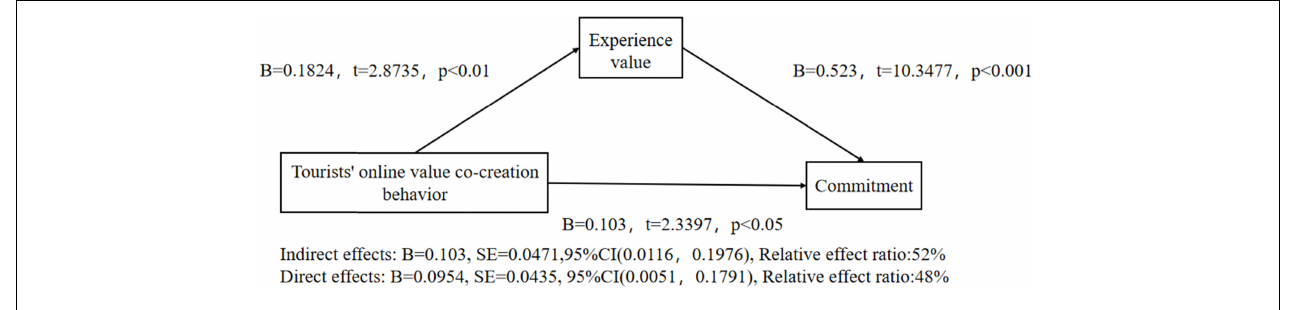
FIGURE 3 | Test of mediation effect of experiential value-2.